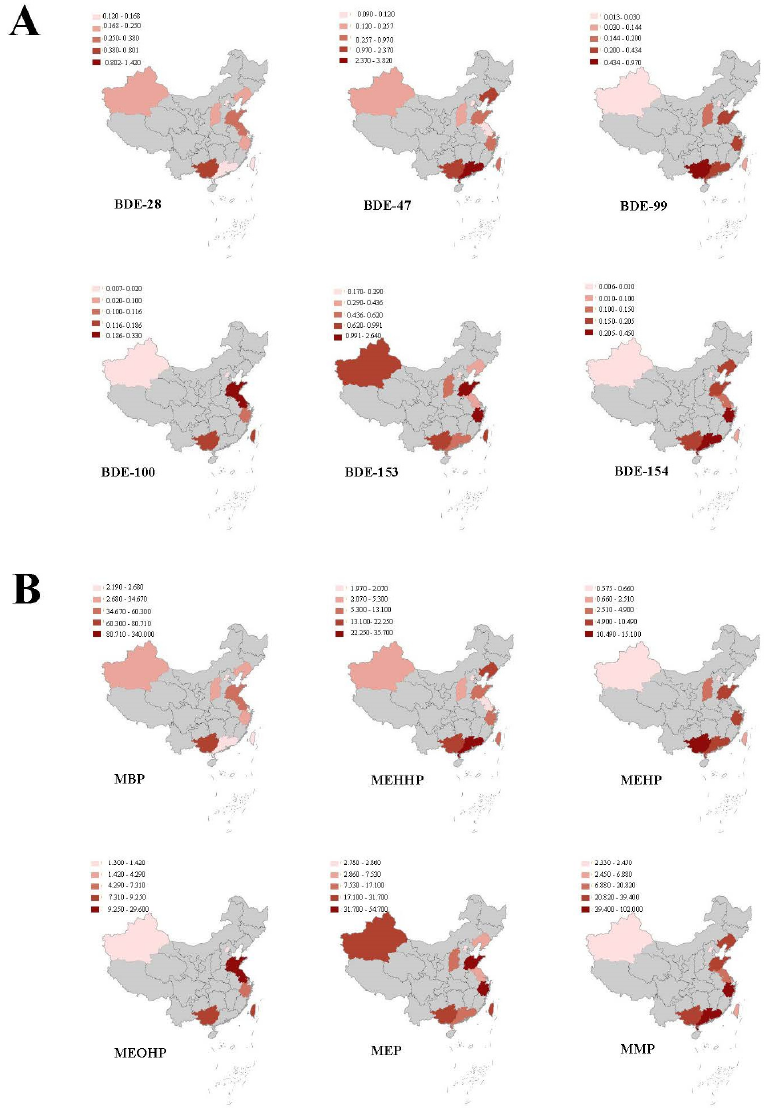
Figure 1. ( A ) Spatial and temporal distribution of PBDE levels in the general Chinese population (ng/g lipid). ( B ) Spatial and temporal distribution of PAE levels in the general Chinese population ( µ g/L). Note: The darker the area, the higher the exposure levels (median exposure concentration of PBDEs and PAEs in this area). The regions with gray marks had no data. (China, 2011–2020). Abbreviations: PBDEs, polybrominated diphenyl ethers; PAEs,